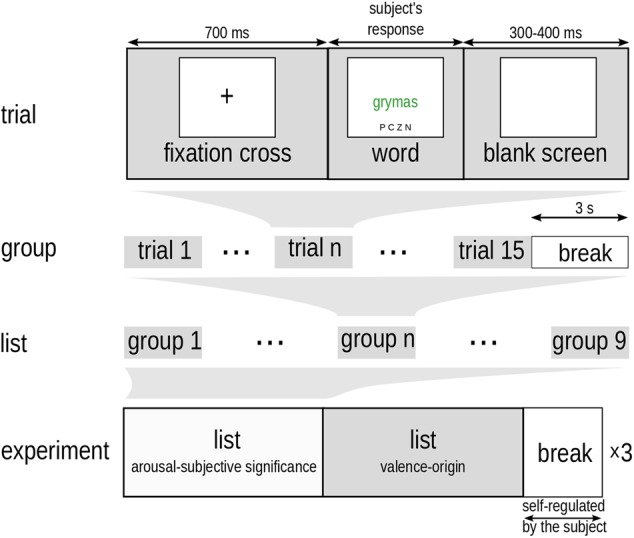
Outline of the experimental protocol.